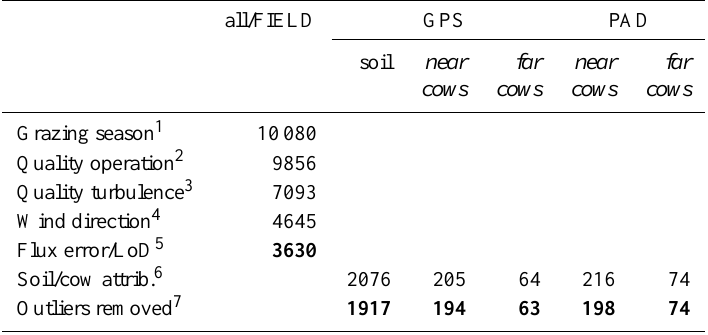
Table 1. Number of available 30min CH 4 fluxes in this study after the application of selection criteria for the three calculation methods (FIELD, GPS, and PAD method). Bold numbers were used for final